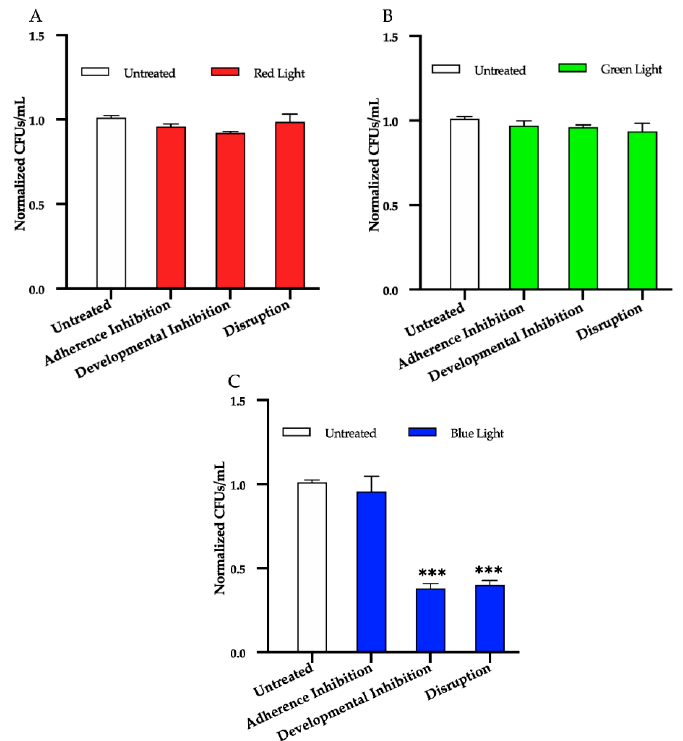
Figure 2. Effects of red, green, and blue visible lights on C. albicans biofilms. C. albicans biofilms were exposed individually to red, green, and blue lights in the adherence inhibition, developmental inhibition, and disruption biofilm assays. Colony forming units per 1mL (CFUs/mL) were measured to determine viable cell counts from the biofilms at the end of each biofilm assay. Effects of ( A ) red light, ( B ) green light, and ( C ) blue light in the three different biofilm assays are shown. Standard deviations are shown for each sample ( n = 3). The average CFUs/mL of the untreated control samples for each assay were normalized to 1. Significance comparisons are relative to the untreated control and were determined using Student’s unpaired two-tailed t-tests assuming unequal variance for p ≤ 0.001 (***).